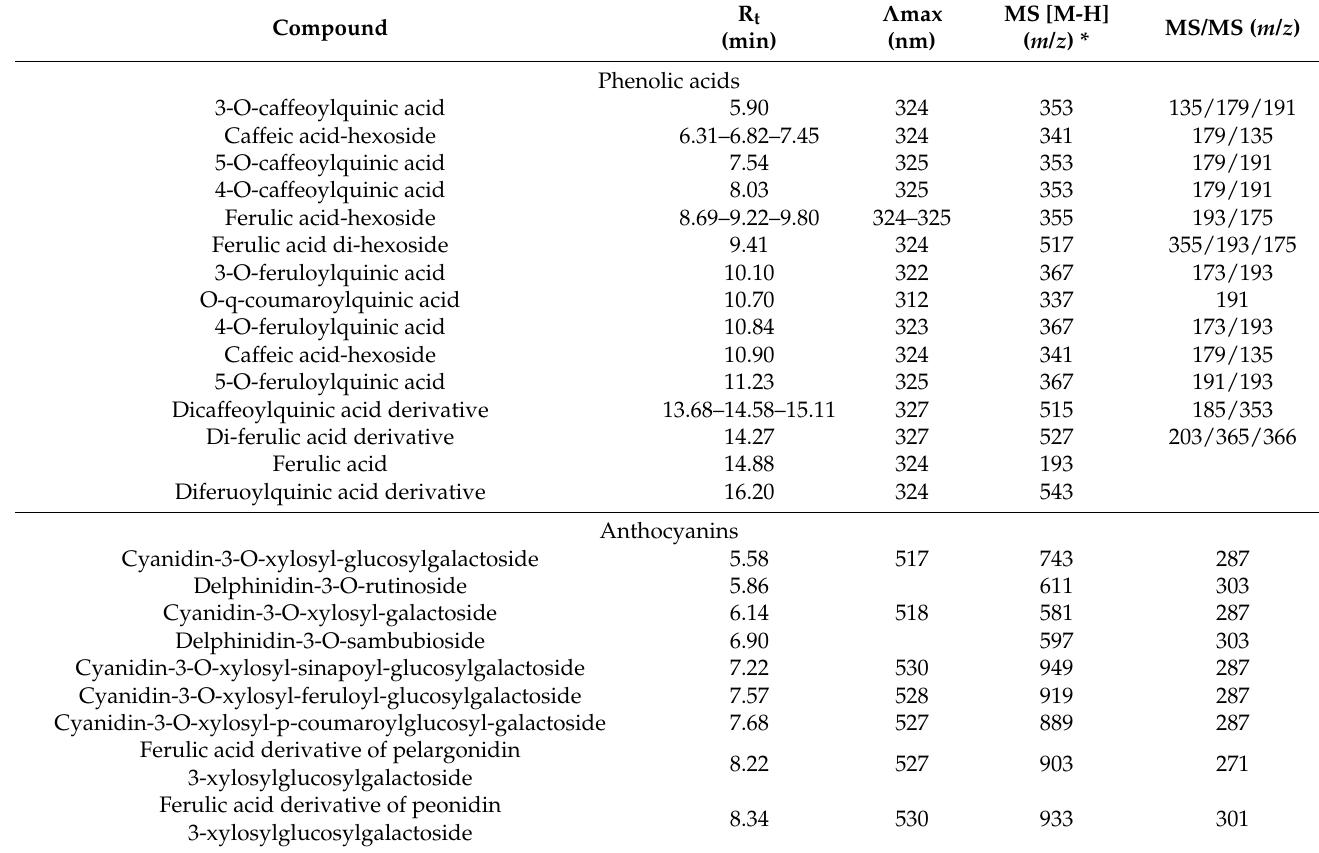
Table 1. Overall phenolic compounds identified in 12 carrots varieties.